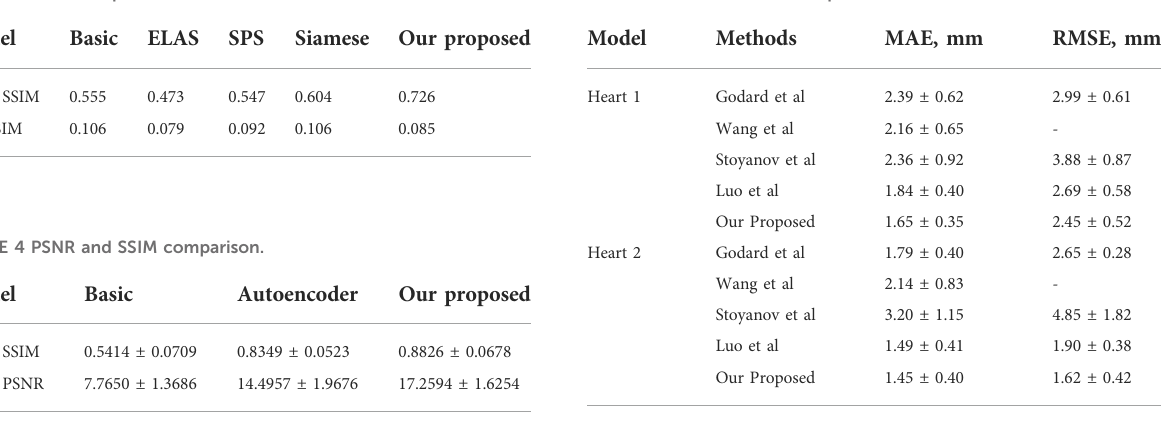
TABLE 3 SSIM comparison.